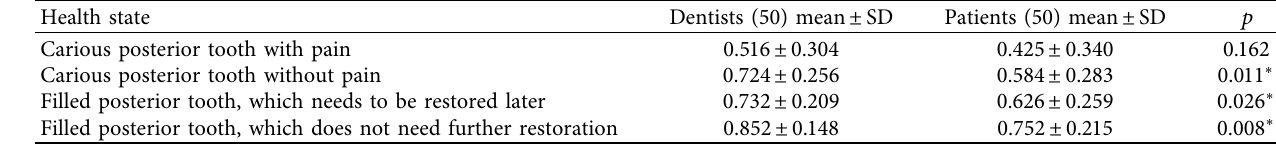
Table 1: Comparison between dentists and patients regarding health status.